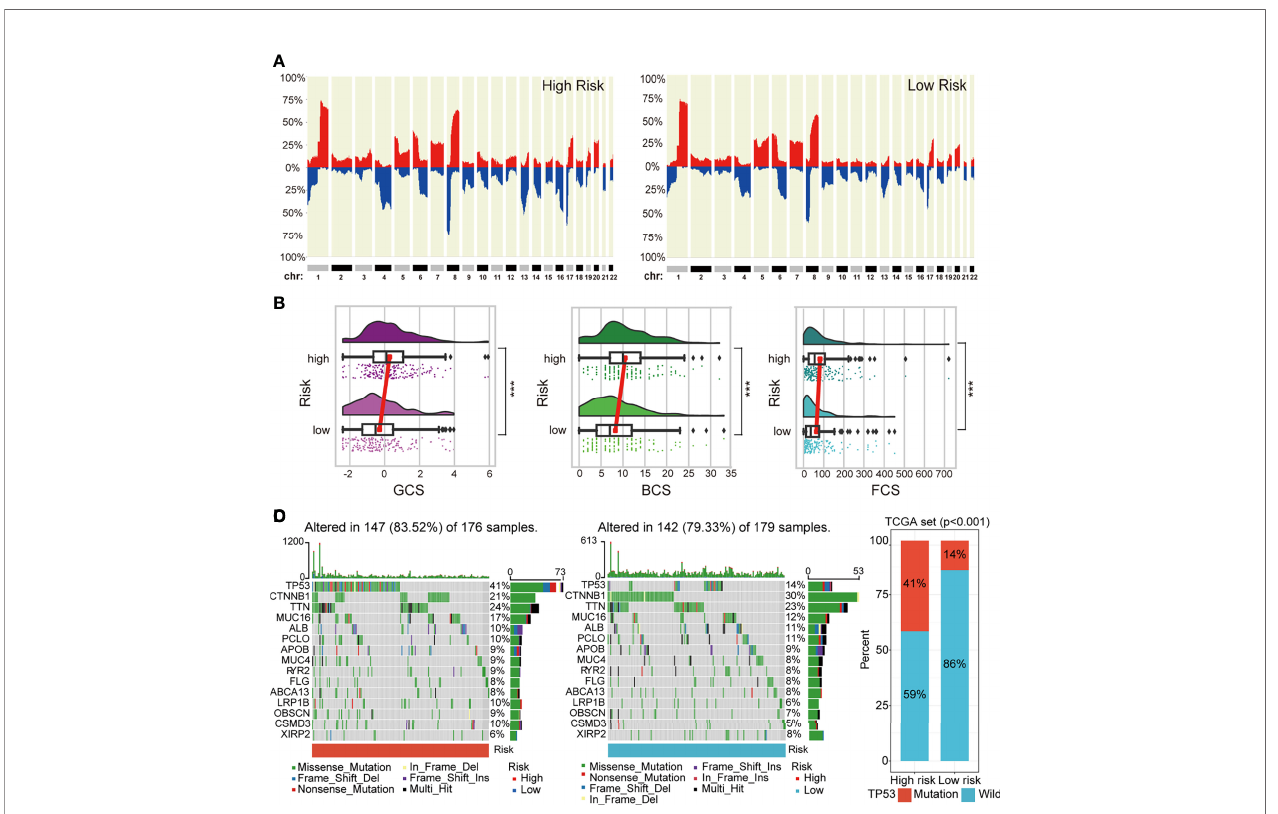
FIGURE 6 | The difference in genomic landscapes between high- and low-risk groups. (A) Genome-wide frequency plots showing the overall frequencies of the CNAs in the two risk groups. (B) Differences in CNA scores (BCS, FCS, and GCS) between different risk groups. (C) Oncoplots of the top 15 signi fi cantly mutated genes in different risk groups. (D) Histogram showing mutation frequency difference of TP53 gene between the low- and high-risk groups. CNAs, copy number alterations.